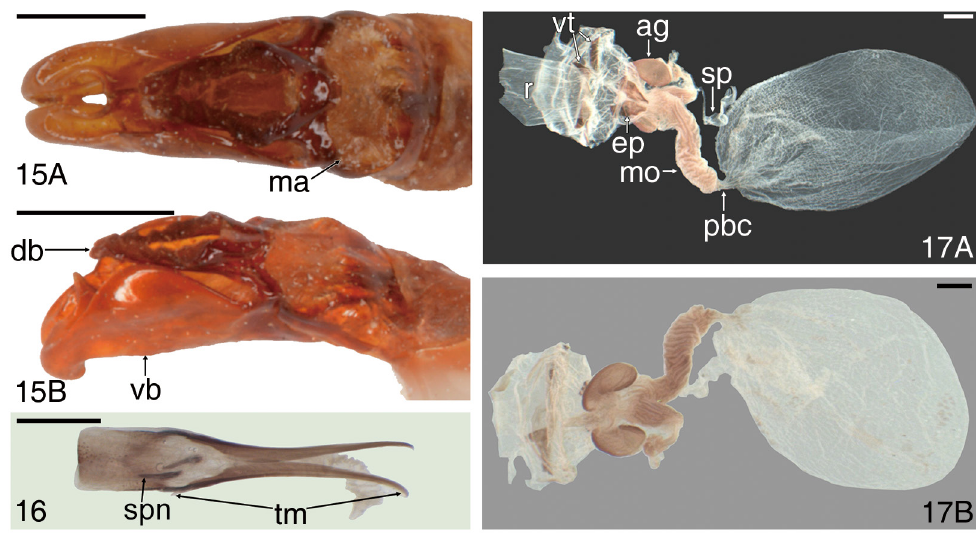
Figs 15–17. Morphotype VI “ Borneensis ”. 15 . Parameres of M. borneensis (Moser, 1918), lectotype (BMNH) in dorsal (A) and lateral (B) views. 16 . Endophallus and temones of M. coxalis (Arrow, 1944), lectotype (BMNH) in dorsal view. 17 . Female genitalia of M. coxalis , paralectotype (BMNH) in dorsal (A) and ventral (B) views. Scale bars = 1.0